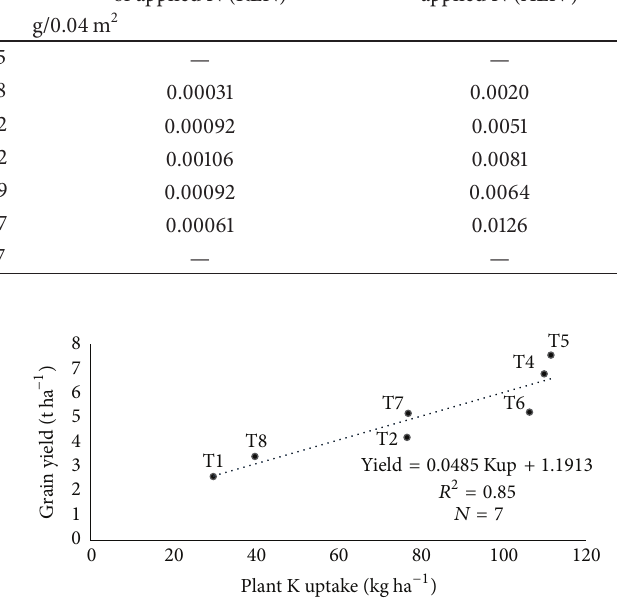
Table 13: Effects of nitrogen application on crop recovery and agronomic efficiency under field trial. Treatment